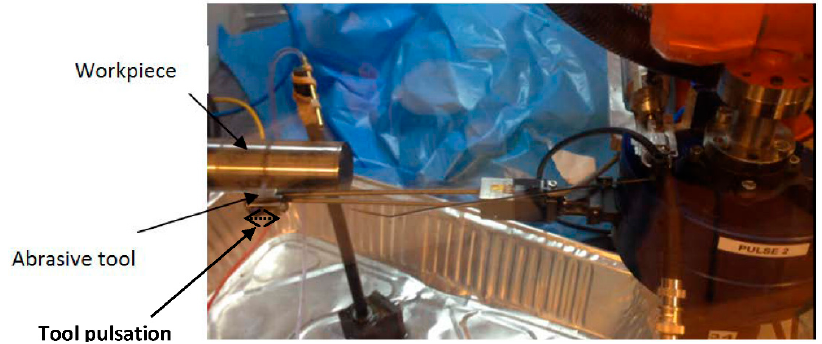
Figure 1. Robot-Assisted Polishing (RAP) machine.